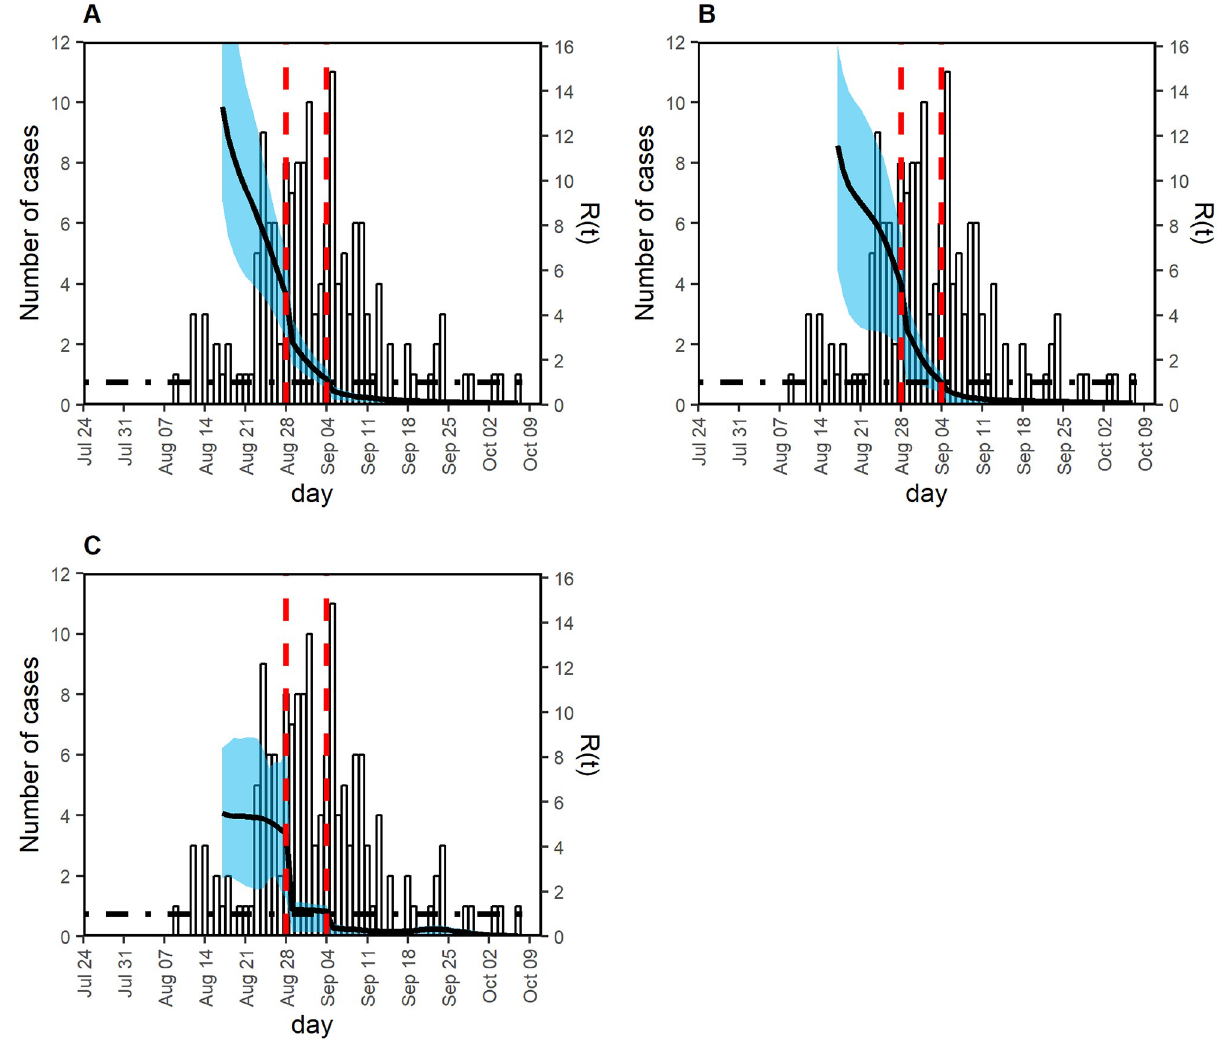
Fig 4. Effective reproduction number in three models with a different number of generations. Left vertical axis shows the observed number of cases (i.e., incidence as a function of the date of illness onset), and the right vertical axis shows the effective reproduction number, illustrated using a black solid line. Two red vertical dashed lines indicate times at which interventions started. The earlier one (from 28 August) included mosquito control and dissemination of outbreak information via mass media. The later vertical line indicates the date on which Yoyogi Park was closed. Black dot-dashed horizontal line indicates the threshold value 1 for the effective reproduction number, below which the outbreak will eventually be controlled. The effective reproduction number was estimated, assuming three different numbers of generations of infection, i.e., (A) two, (B) three, and (C) four generations excluding generation zero. Owing to the uncertainty of estimation during the very early stage of the epidemic, the effective reproduction number was plotted from 17 August. The shaded cyan area represents the 95% confidence interval (CI) of the effective reproduction number, calculated using 100 bootstrap